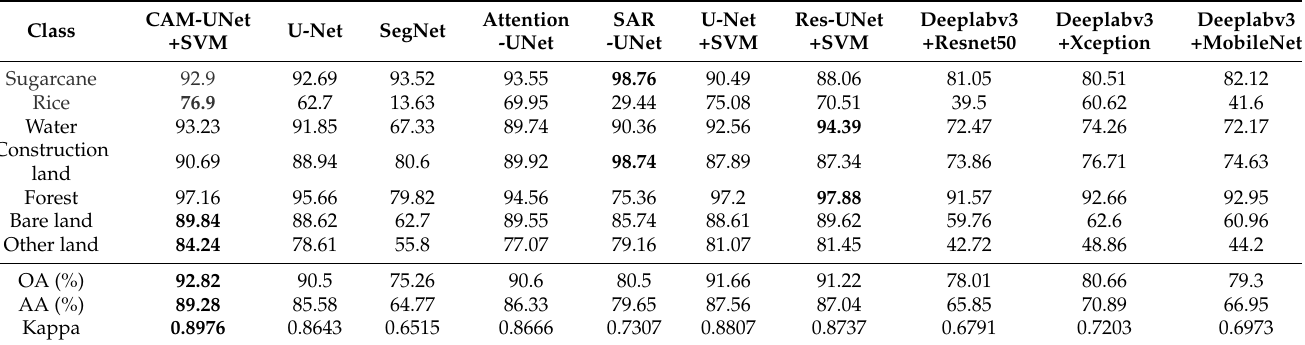
Table 5. Comparison of the classification accuracy of different methods on the test set of remote sensing images in the study area (%).